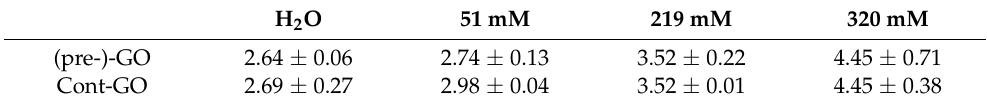
Table 4. Differences in log10 CFU/cm 2 between (pre-treatment) GO and control